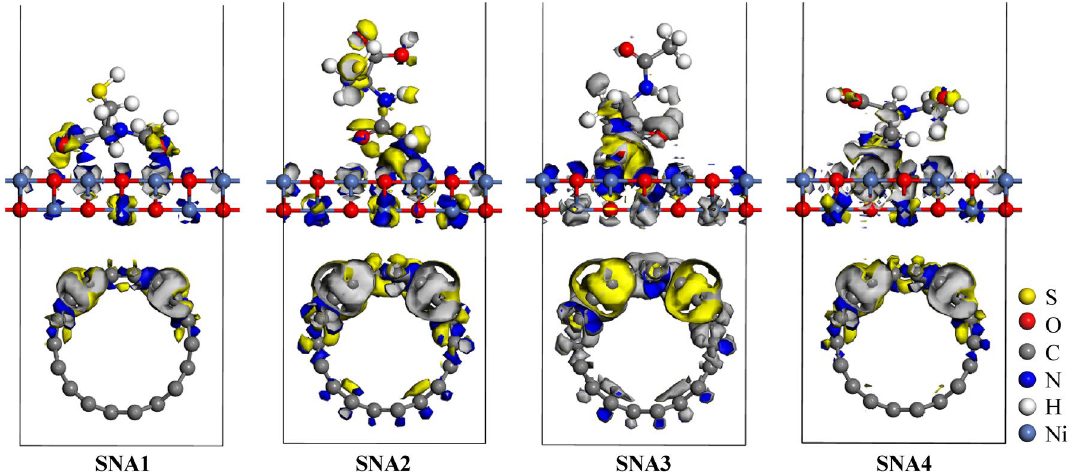
Figure 11. 3D charge density differences upon N-acetylcysteine molecule adsorption on the NiO–SWCNTs surface showing regions of charge depletion (yellow) and accumulation (blue) with an isovalue of 0.007 e Å −3 .